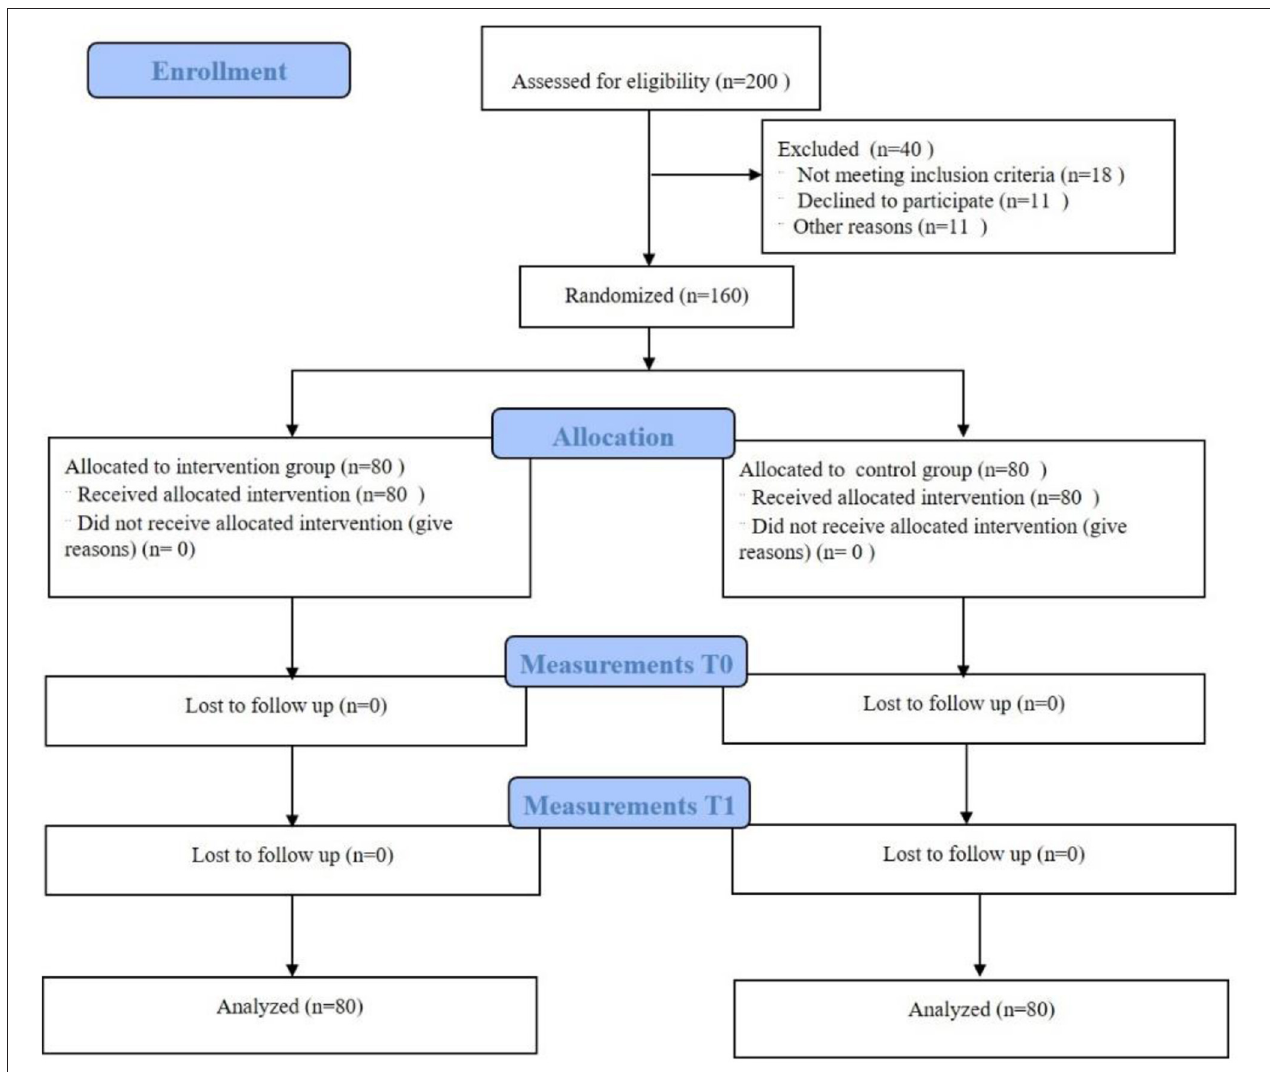
FIGURE 1 | Flow chart of the pilot